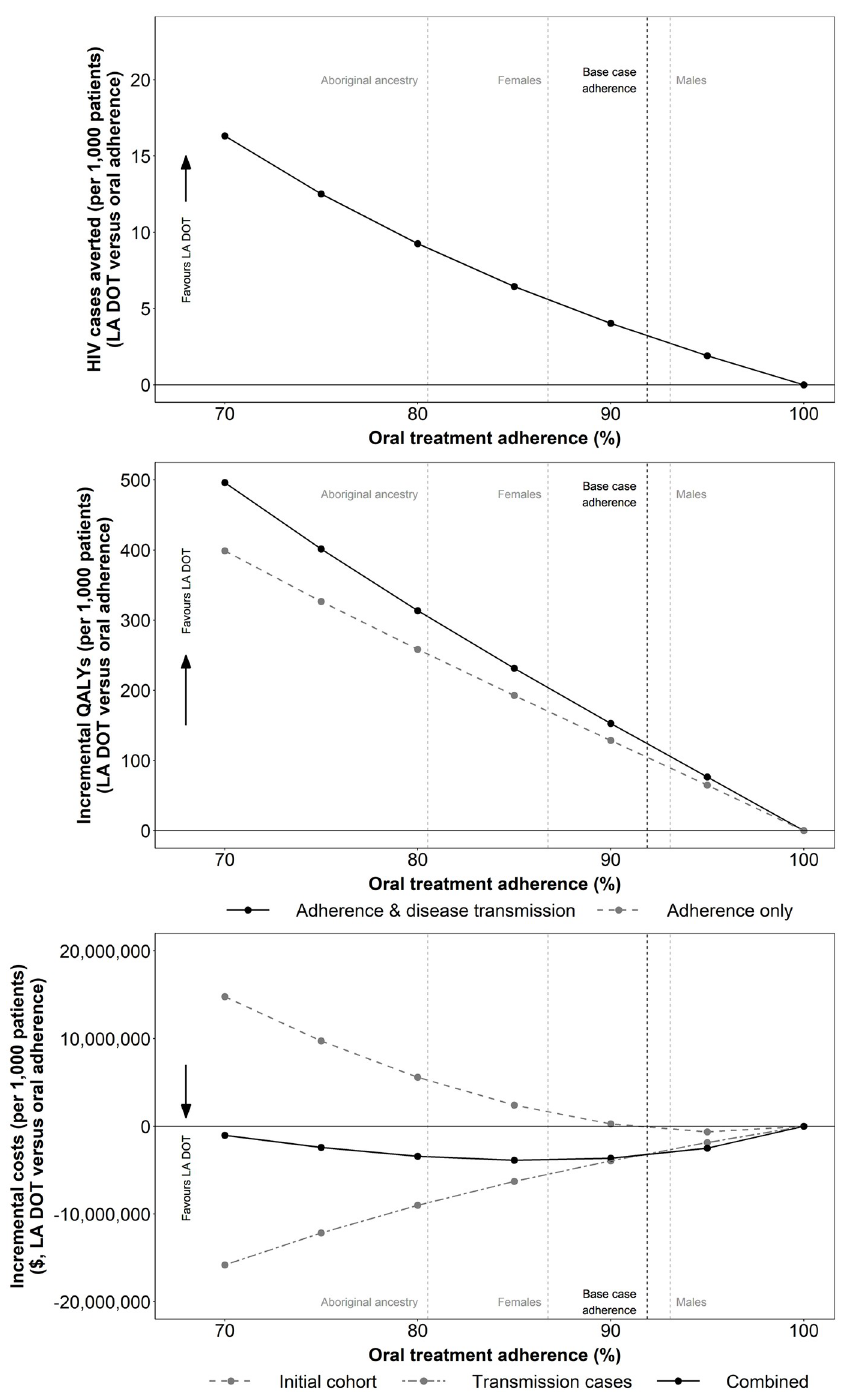
Fig 5. Impact of average baseline population treatment adherence on the incremental number of transmissions, QALYs and total costs per 1,000 patients treated (LA DOT vs oral adherence). Abbreviations: DOT: directly observed therapy; LA: long-acting; QALY: quality adjusted life